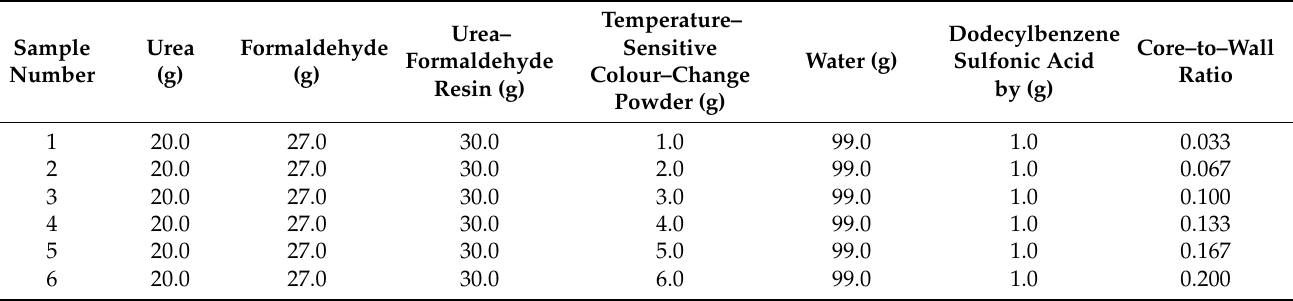
Table 1. Experimental raw material proportioning